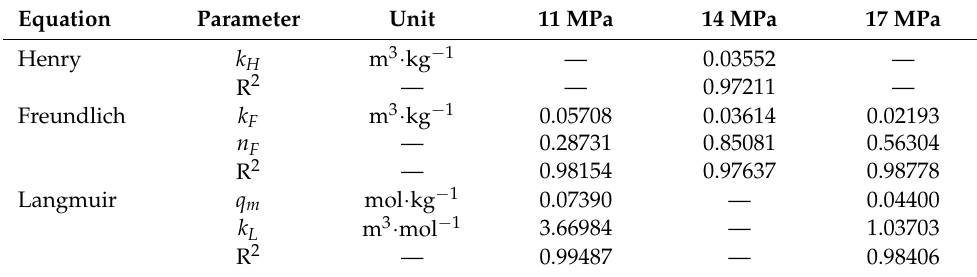
Figure A1. Uptake of RuCp 2 on MCM ‐ 48 at 333 K and different pressures; experimental data taken from [64]. Table A1. Adsorption isotherm parameters for RuCp 2 from scCO 2 on MCM ‐ 48 solution at 333 K and different pressures [64].